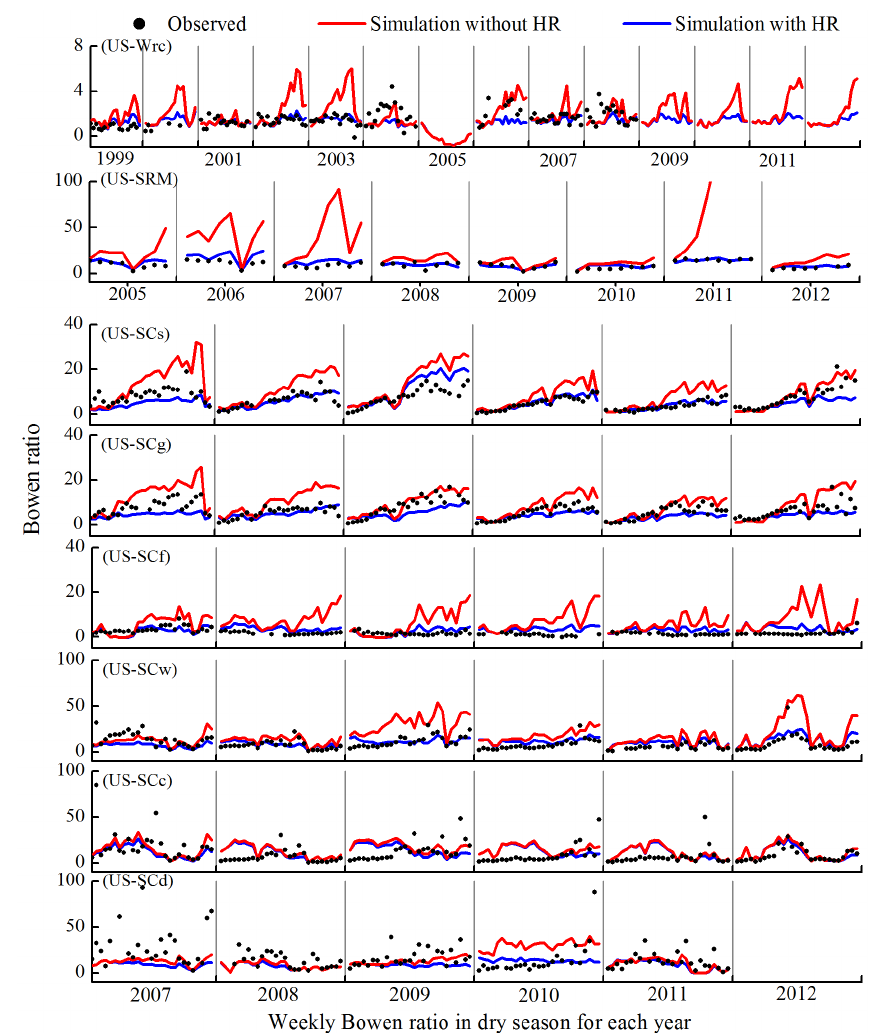
Figure 8. Observed and simulated weekly Bowen ratio during dry